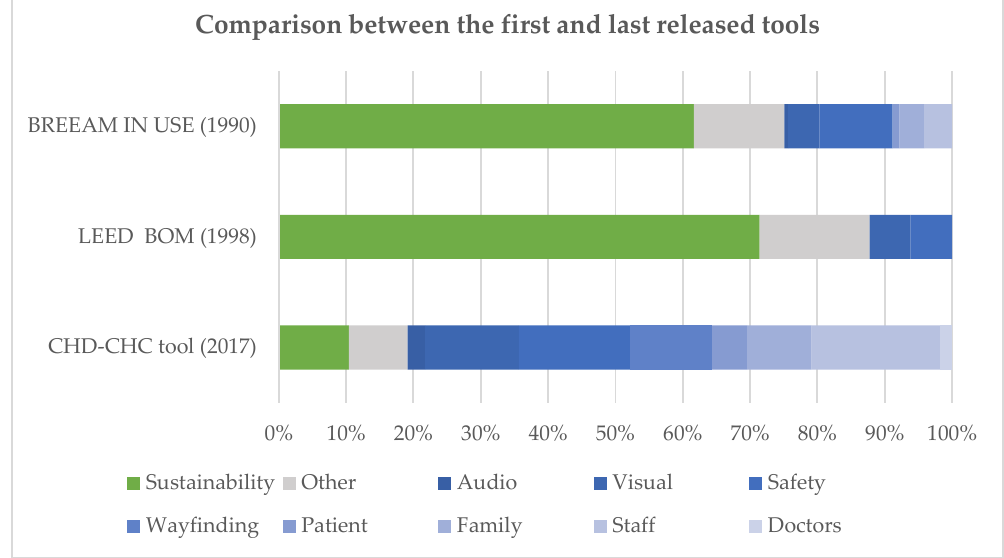
Figure 5. Comparison between the first developed tools (BREEAM and LEED), with focus on sustainability, and the last released one, which has a prevalence of health-related indicators (CHD-CHC).